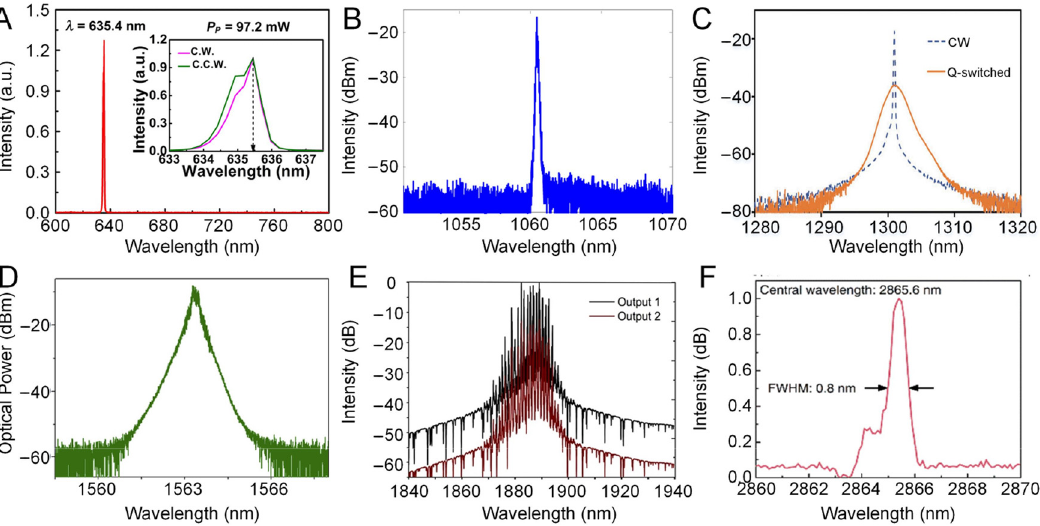
Figure3: CNT-SAbasedQ-switchedfiberlasercoveringthespectralregionfromvisibletomid-infrared.(A)635nmbasedonPr:ZBLAN fi ber,Li etal.[52].©IEEE2018;(B) ∼ 1060nmbasedonYb-doped fi ber,Lietal.[67].©OpticalSocietyofAmerica2014;(C)1300nmbasedonPr-doped fl uoride fi ber,Ahmadetal.[98].©ChinesePhysicalSocietyandIOPPublishingLtd2019;(D) ∼ 1560nmbasedonEr-doped fi ber,Xuetal.[68]. ©ElsevierLtd2015;(E) ∼ 1900nmbasedonTm-doped fi ber,Chernyshevaetal.[69].©SpringerNature2016;(F) ∼ 2800nmbasedonHo/Prco- doped ZBLAN fi ber, Wei et al. [53]. © IEEE